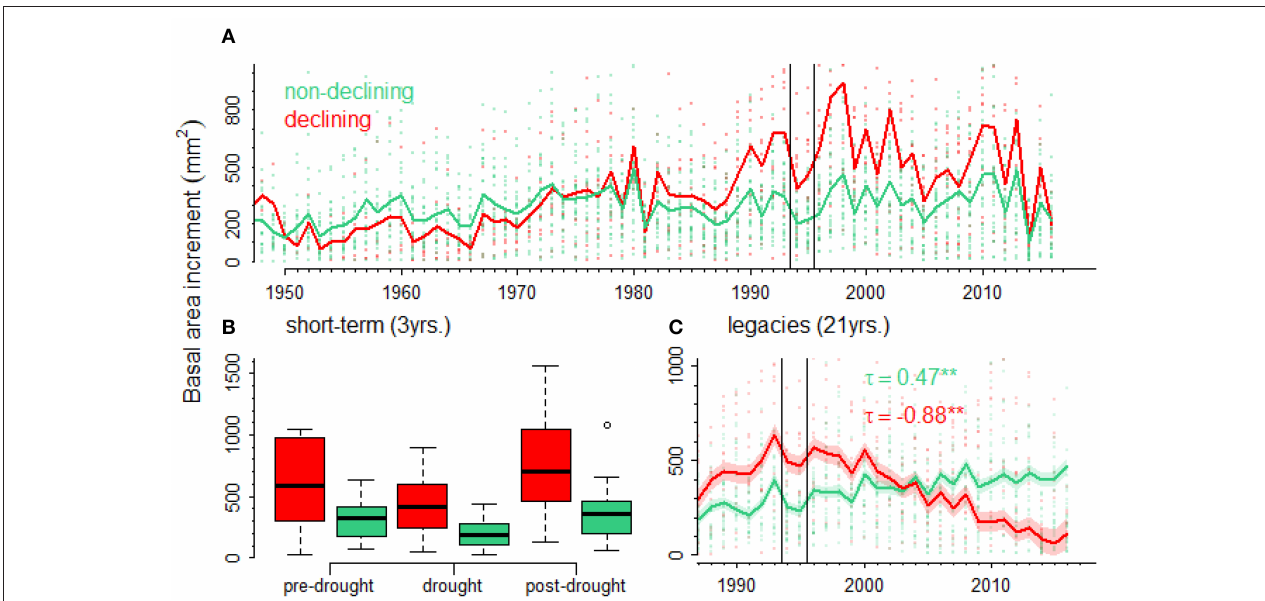
FIGURE 5 | Short- and long-term growth (BAI, basal area increment) responses to drought in declining (red lines, symbols, and bars) and non-declining (green lines, symbols, and bars) black pines. The effect of the 1994–1995 drought (vertical lines delimit BAI values during that period) on growth of declining vs. non-declining black pines is shown (A) . Short-term effects of drought on growth (B) were studied by considering the growth three years before (pre-drought), during the drought (drought) and three years after the drought (post-drought). Long-term (legacy) effects (C) were studied by considering growth trends ( τ , Kendall tau statistics; significance level, ** p < 0.01) of predicted growth values for declining and non-declining